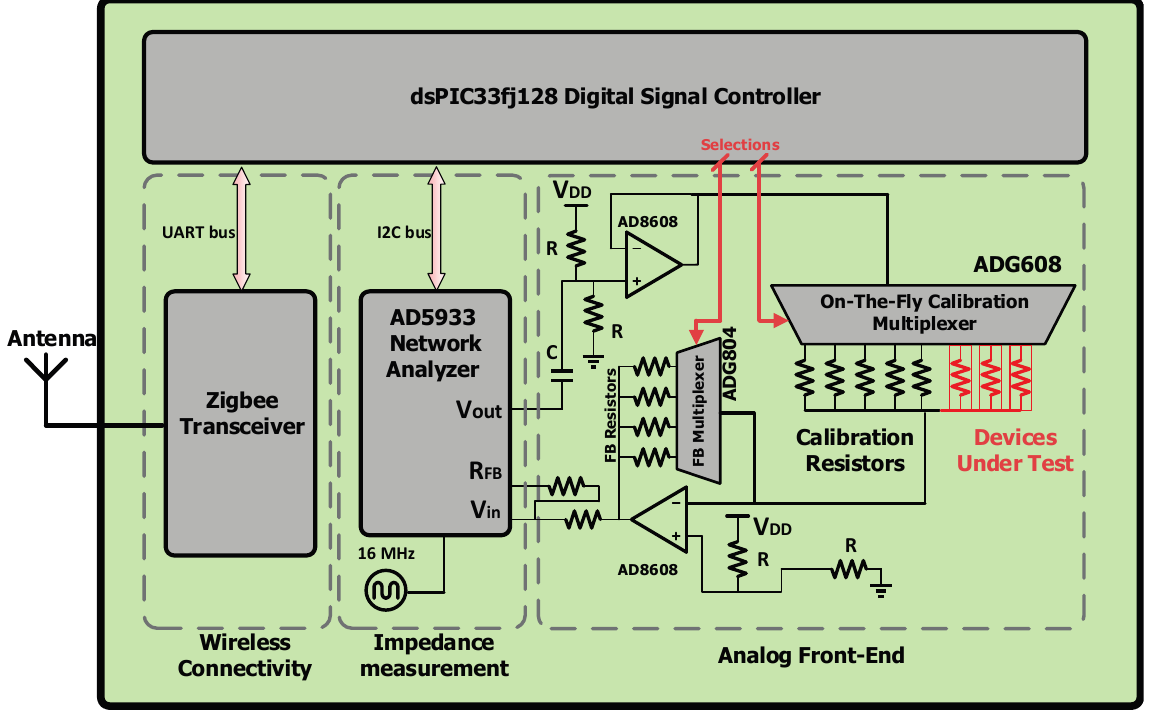
Figure 2. Functional block diagram of the dielectric impedance spectroscopy (DIS)